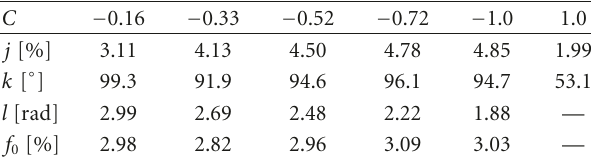
Table 3: Biaxial stress ratio in each experimental